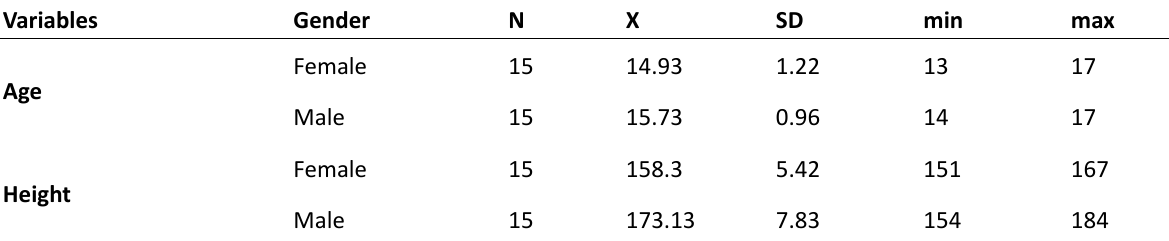
Table 1. The Demographical Properties of the Participant Females and Males Variables